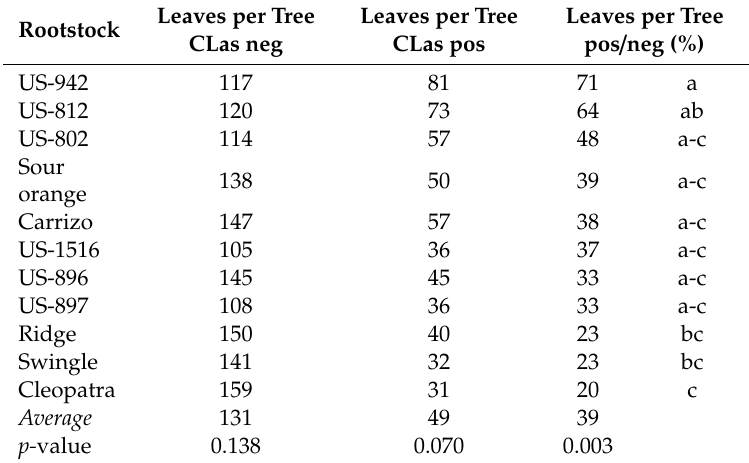
Table 7. Number of leaves per tree at 50